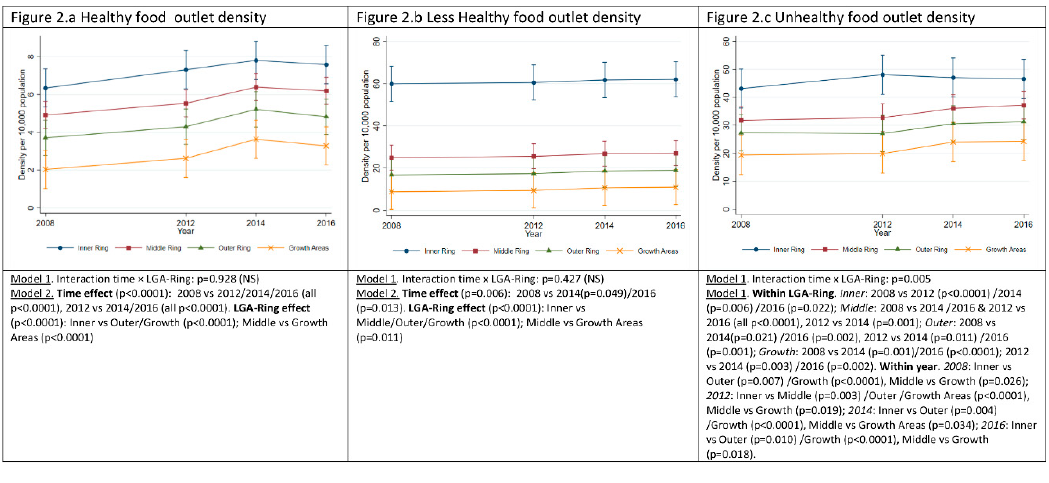
Figure 2. Density of healthy, less healthy and unhealthy food outlets over the period 2008-2016 across local government areas grouped by distance from Greater Melbourne Central Business District (LGA-